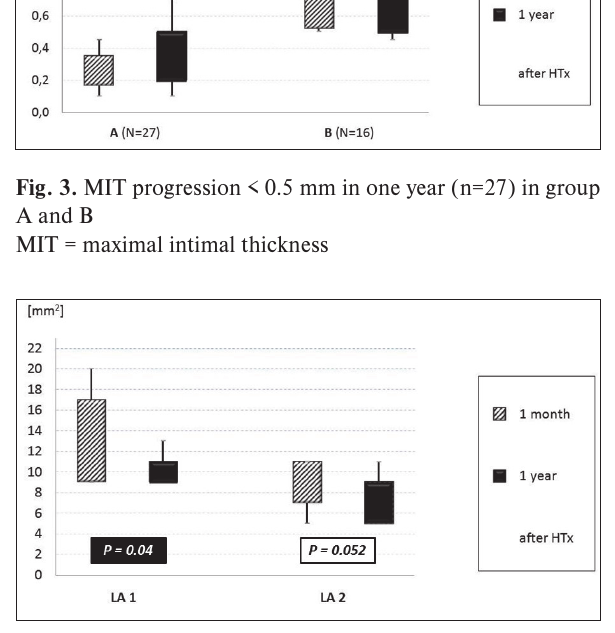
Fig. 4. DTA progression over one year = VA1 + VA2 VA = vessel area